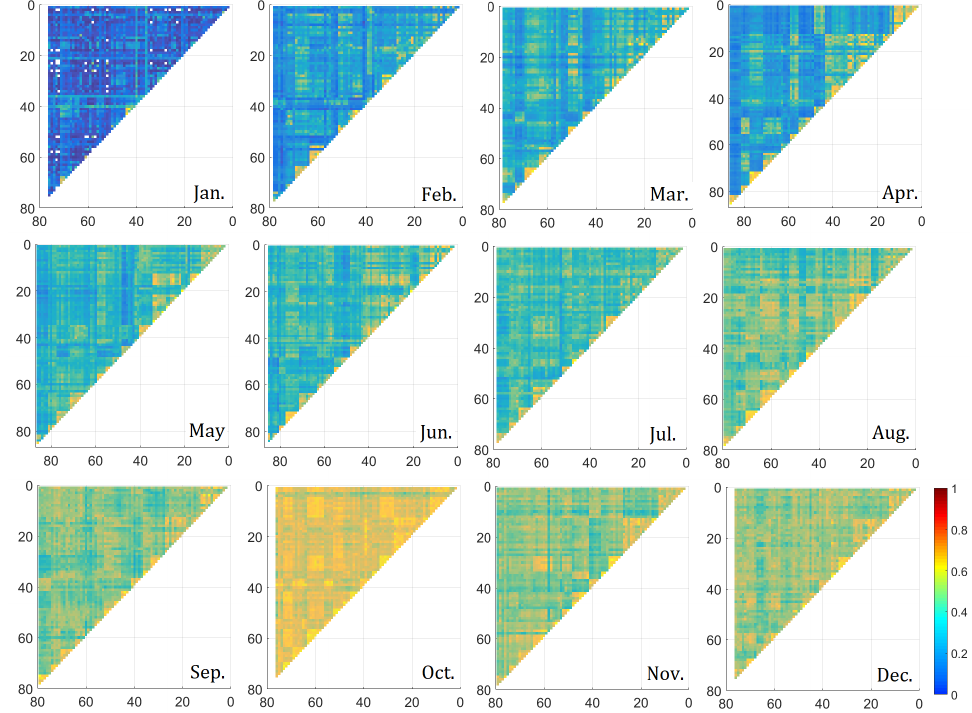
Figure 4. Triangular matrix graphs of q max between station pairs in the BTH Region for each month of 2019. The principal diagonal of the triangular matrix is not shown for the same reason as in Figure